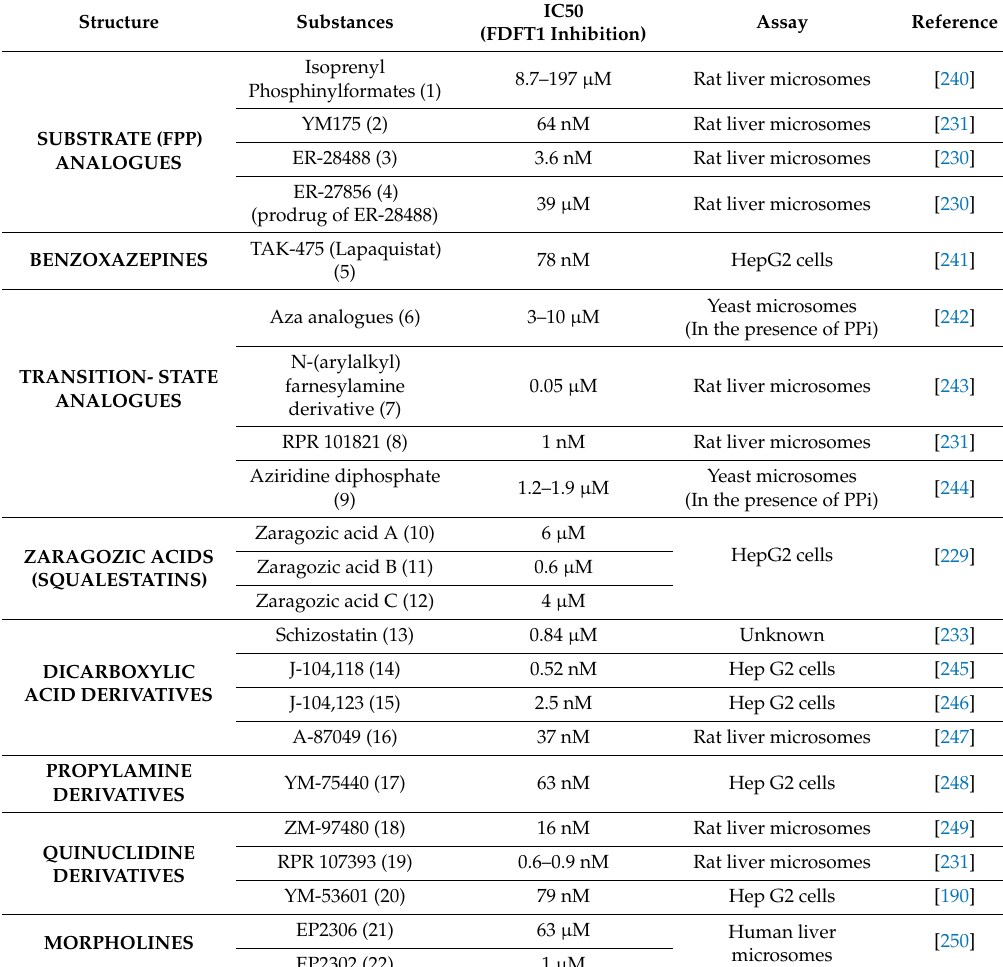
Table 2. Inhibitors of FDFT1 classified by